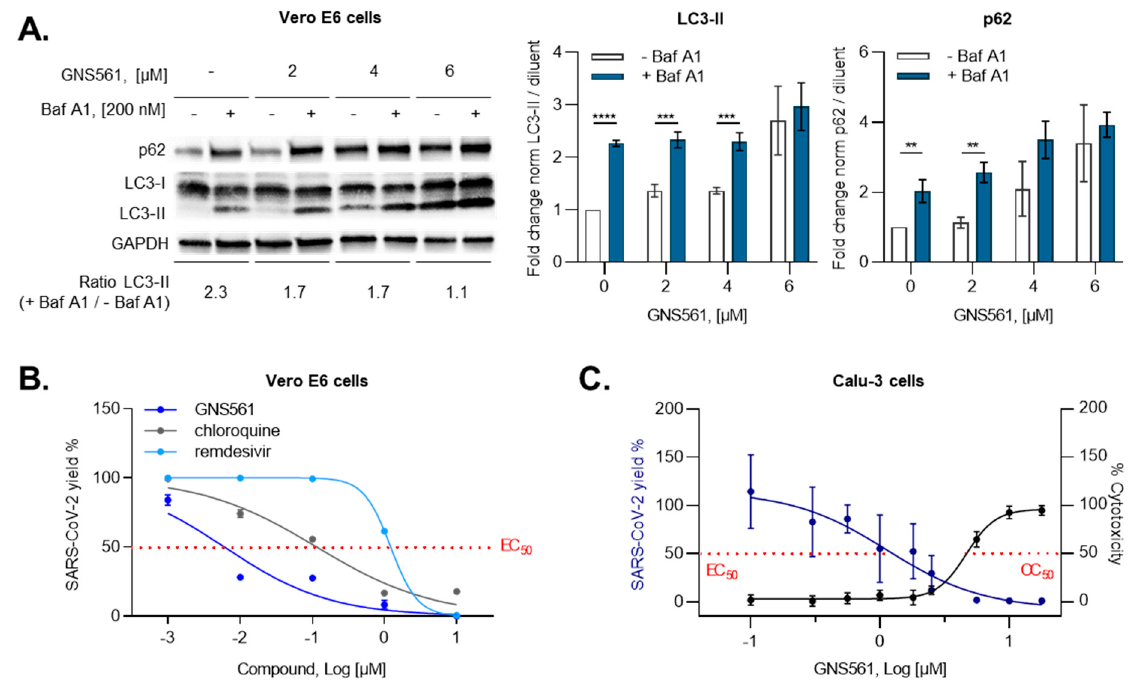
Figure 1. GNS561 antiviral activity. ( A ) GNS561 treatment blocks autophagic flux during SARS-CoV-2 infection. LC3-II and p62 protein expression was evaluated in uninfected Vero E6 cells treated with GNS561 by Western blotting and normalized to the GAPDH signal. Autophagy inhibition was evaluated in the presence (blue) or absence (white) of 200 mM bafilomycin A1 (Baf A1) treatment added 4 h before the end of the experiment. Representative autoradiograms are shown associated with the LC3-II (+ Baf A1/ − Baf A1) ratio. Data values represent the mean ± SD from 3 independent experiments. Statistical analysis performed with unpaired t-test. *, p ≤ 0.05; **, p ≤ 0.01; ***, p ≤ 0.001; ****, p ≤ 0.0001. ( B , C ) GNS561 exhibits strong antiviral activity against SARS-CoV-2 replication. After 2 h of treatment with different compounds in the dose range, Vero E6 and Calu-3 cells were infected with SARS-CoV-2 strains for an additional 24 or 48 h, respectively. The viral yield was quantified and represented on the left axis of the graph. Values are the mean ± SD of at least triplicate assays conducted in triplicate. ( B ) The results obtained for Vero E6 cells treated with remdesivir, chloroquine, or GNS561 and infected with the USA-WA1/2020 strain are represented in light blue, gray, and dark blue, respectively. ( C ) The results obtained for the Calu-3 cell line treated with GNS561 and infected with the IHUMI-6 strain are represented with the half-maximal effective and cytotoxic concentrations on the left (blue line) and right (black line) axes on the graph.